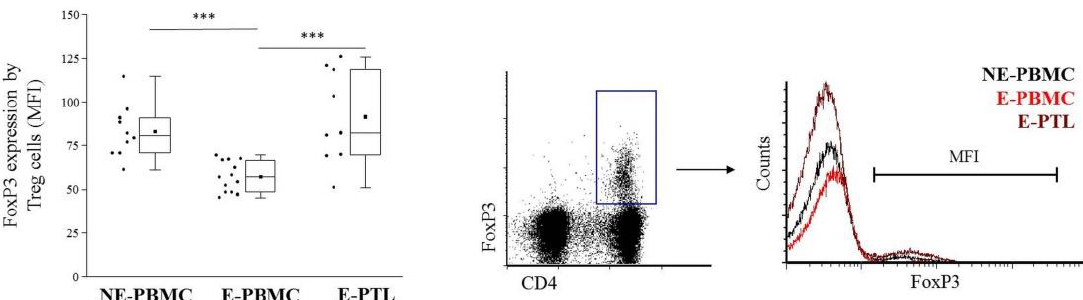
Figure 2. Comparison of the Mean Fluorescent Intensity (MFI) values of FoxP3 positive peripheral (PBMC) and peritoneal (PTL) Treg cells in non-endometriotic (NE) women and patients with endometriosis (E). Left: The solid bars represent medians of 10, 12, and 11 determinations, the boxes show the interquartile ranges, and the whiskers show the most extreme observations. The middle square within the box represents the mean value. Statistically significant di ff erences with p -values of *** < 0.01 are indicated. Right: representative dot plot and histogram figures showing the analysis of CD4 +/ FoxP3 + Treg cells in NE-PBMC, E-PBMC and E-PTL